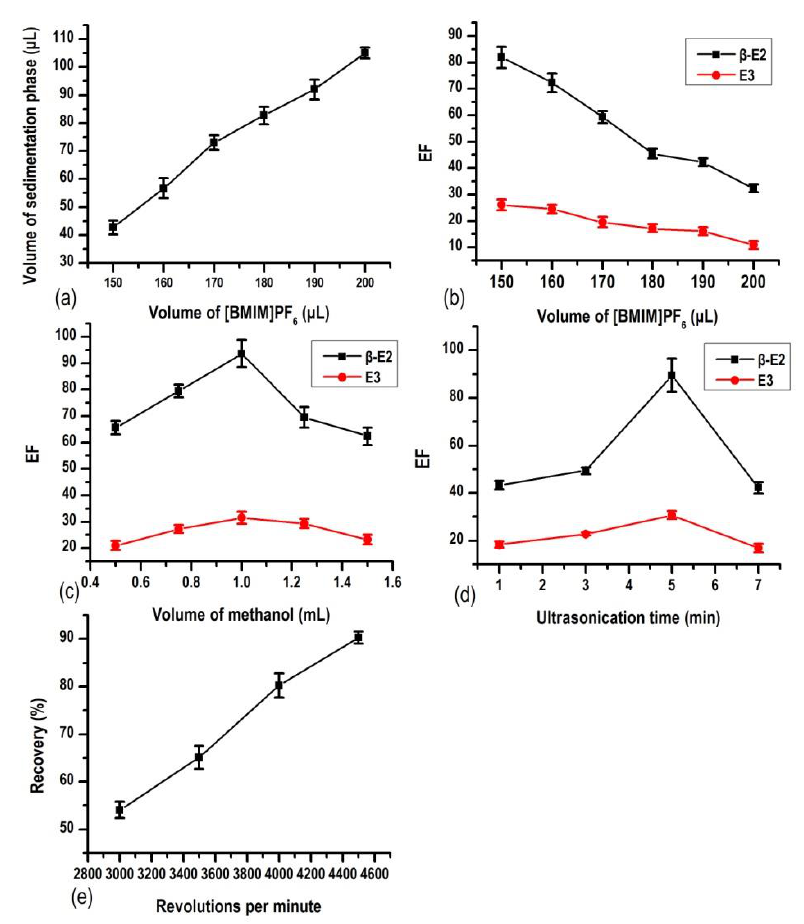
Figure 3. E ff ect of 1-butyl-3-methylimidazolium hexafluorophosphate ([BMIM]PF6) volume on Figure 3. Effect of 1-butyl-3-methylimidazolium hexafluorophosphate ([BMIM]PF6) volume on ( a ) ( a ) sedimentation phase volume; and e ff ect of ( b ) [BMIM]PF6 volume, ( c ) methanol volume, ( d ) and sedimentation phase volume; and effect of ( b ) [BMIM]PF6 volume, ( c ) methanol volume, ( d ) and ultrasonication time on enrichment factor (EF) and e ff ect of centrifugal rotational speed on ultrasonication time on enrichment factor (EF) and effect of centrifugal rotational speed on recovery.